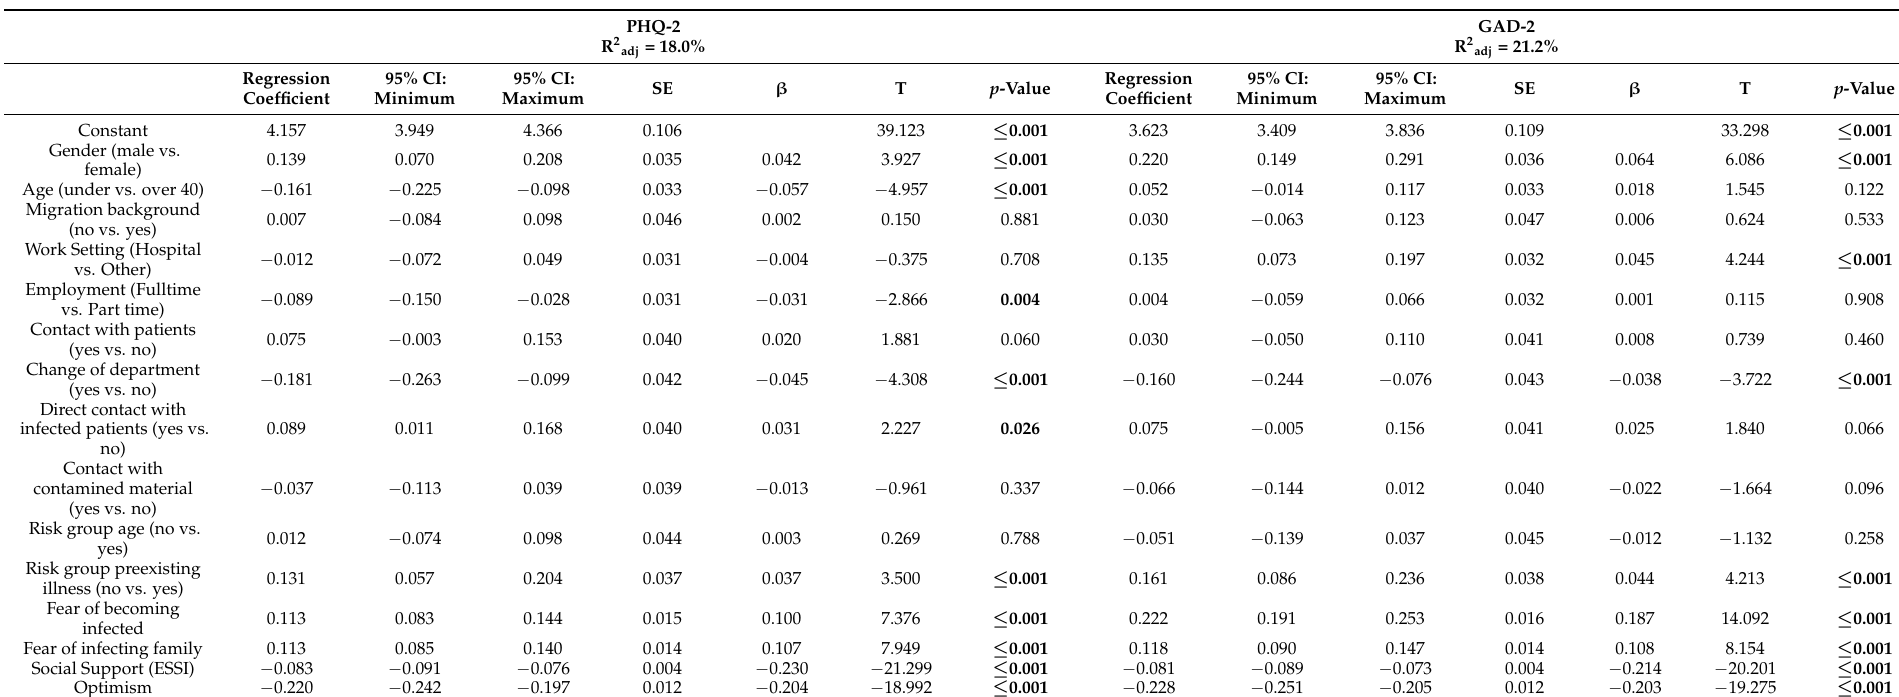
Table 6. Linear regression analyses for the severity of depressive (PHQ-2) and generalized anxiety symptoms (GAD-2) for the total sample of healthcare